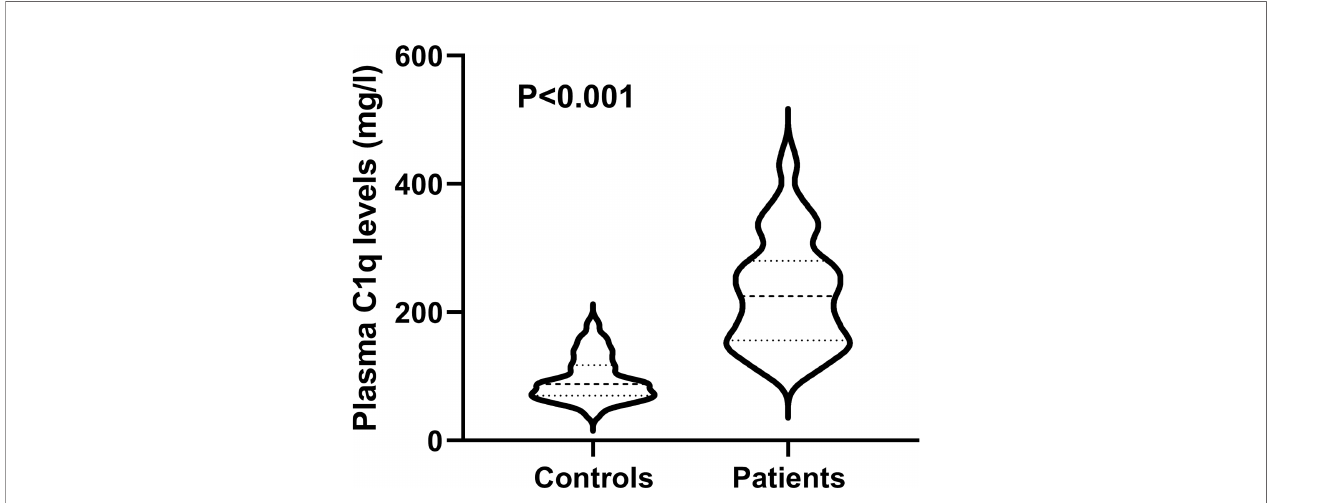
FIGURE 2 | Differences in terms of plasma C1q levels between healthy controls and patients with intracerebral hemorrhage. Plasma C1q levels were reported as median (upper-lower quartiles). Plasma C1q levels were signi fi cantly higher in patients than in healthy controls using the Mann – Whitney U test (P < 0.001).